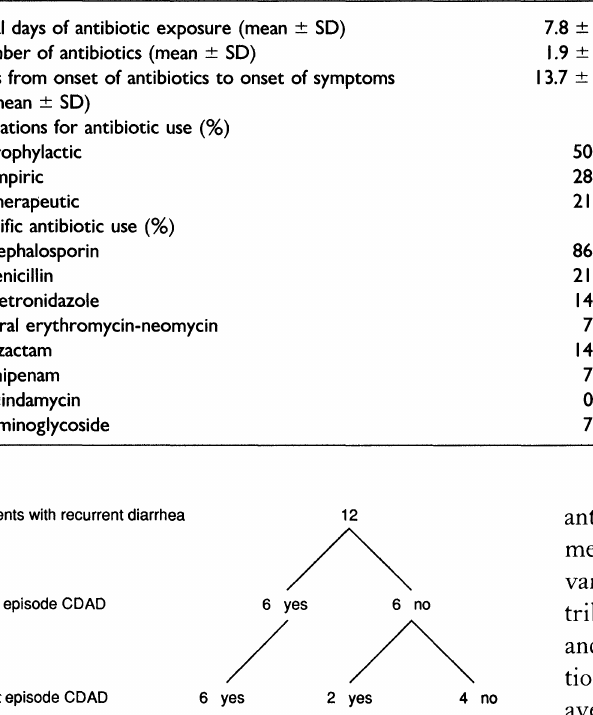
Fig. 3. Influence of a prior episode of CDAD on recurrent diarrhea. Risk of recurrence with CDAD was highly associ- ated (P 0.030) with a history of